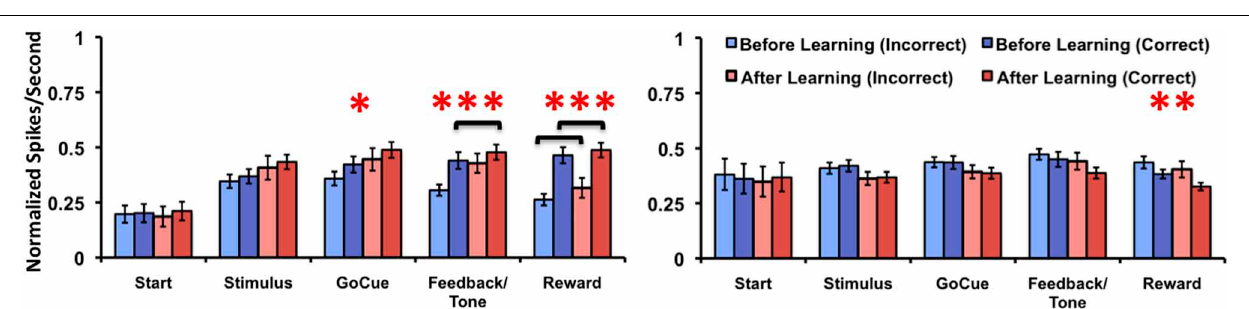
illustrates the average firing rate of Class II neurons (“ ∗ ” denotes statistical significance relative to baseline rates, and “ (cid:2) ” denotes difference between correct and incorrect firing rates within the same epoch; paired Friedman Analysis of Variance with Dunn’s correction, p < 0 . 05).